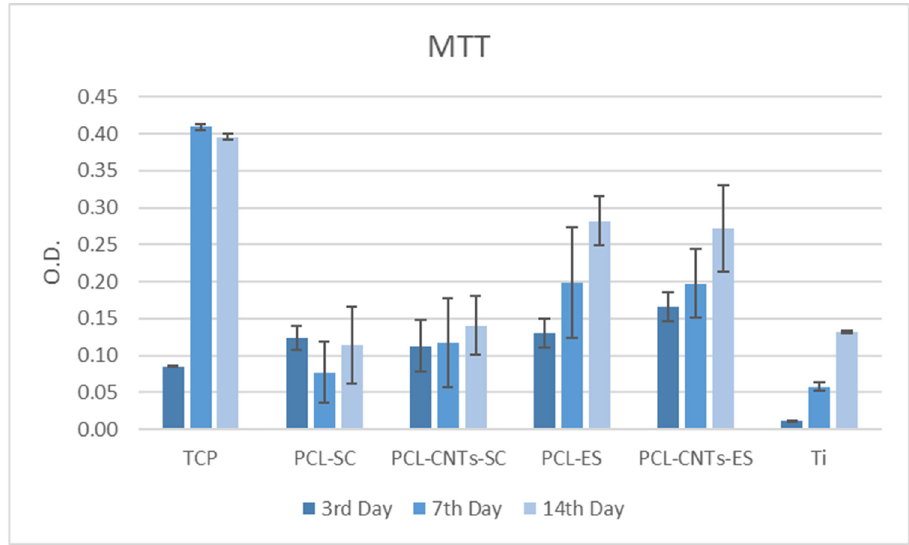
Figure 7. Quantification of MTT levels on all substrates after 3, 7, and 14 days of incubation. It is assumed that cells behavior becomes more stable after longer incubation periods.